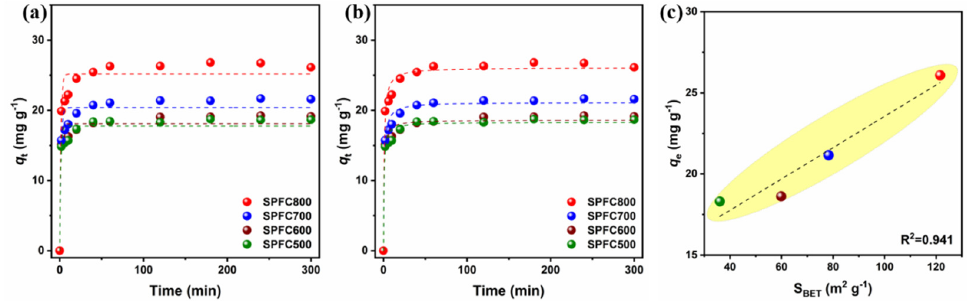
Figure 2. Pseudo first ( a ); pseudo second ( b ) order kinetic models; and the correlation analysis between q e and S BET ( c ). (Experimental conditions: [BPA] = 10 mg L − 1 , and [SPFCx] = 0.2 g L − 1 ). Table 2. The parameters obtained by fitting with adsorption kinetic equation.